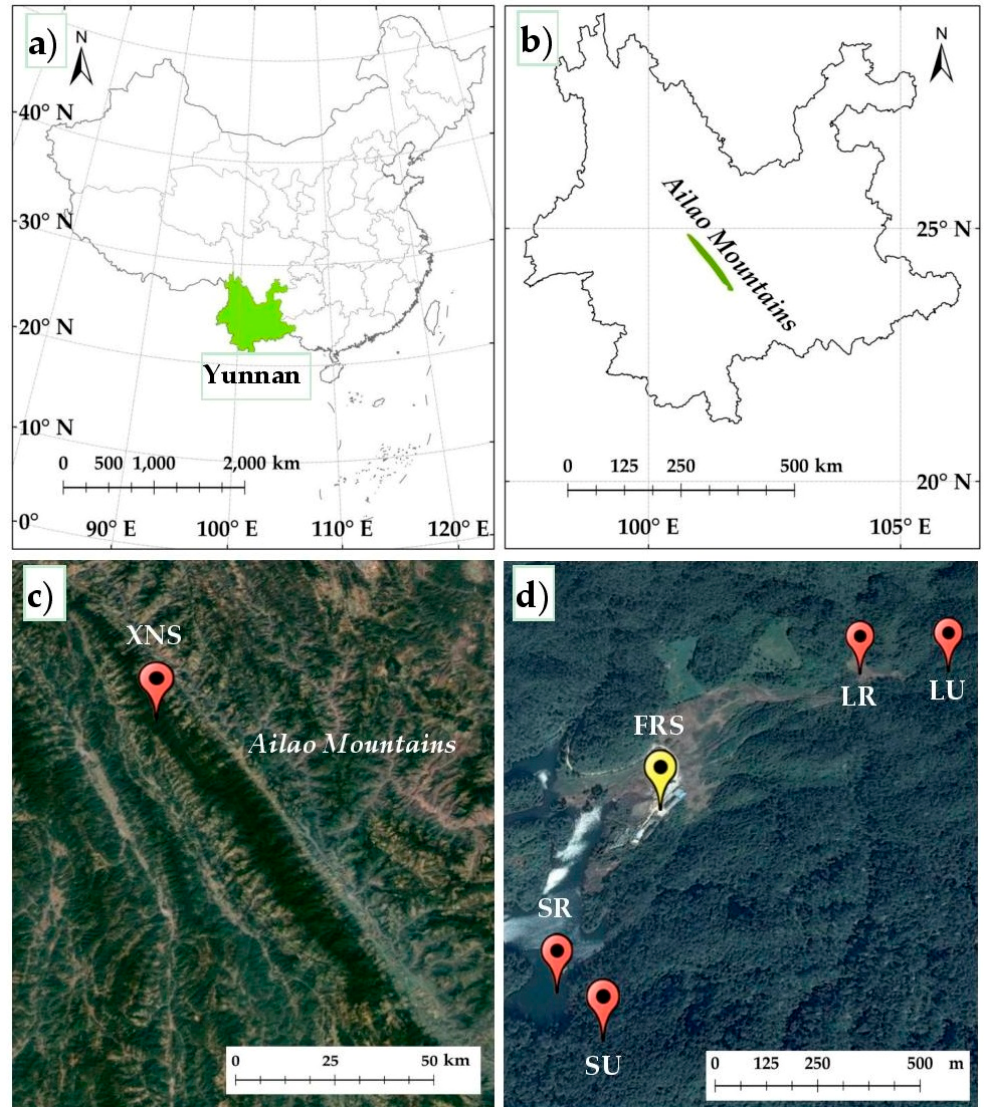
Figure 1. Location of the study area and four soil profiles at the Ailao Mountains Natural Reserve, southwestern China. ( a ) Yunnan province of China with bright green color; ( b ) Ailao Mountains with dark green color in Yunnan province; ( c ) location of the study area named Xujiaba Nature Sanctuary (XNS) in the Ailao Mountains; and ( d ) location of the four soil profiles (LU in the upland forest and LR in the riparian shrubby meadow of the Laojunshanshen watershed, and SU in the upland forest and SR in the riparian shrubby meadow of the Sankeshu watershed) near the forest research station (FRS).